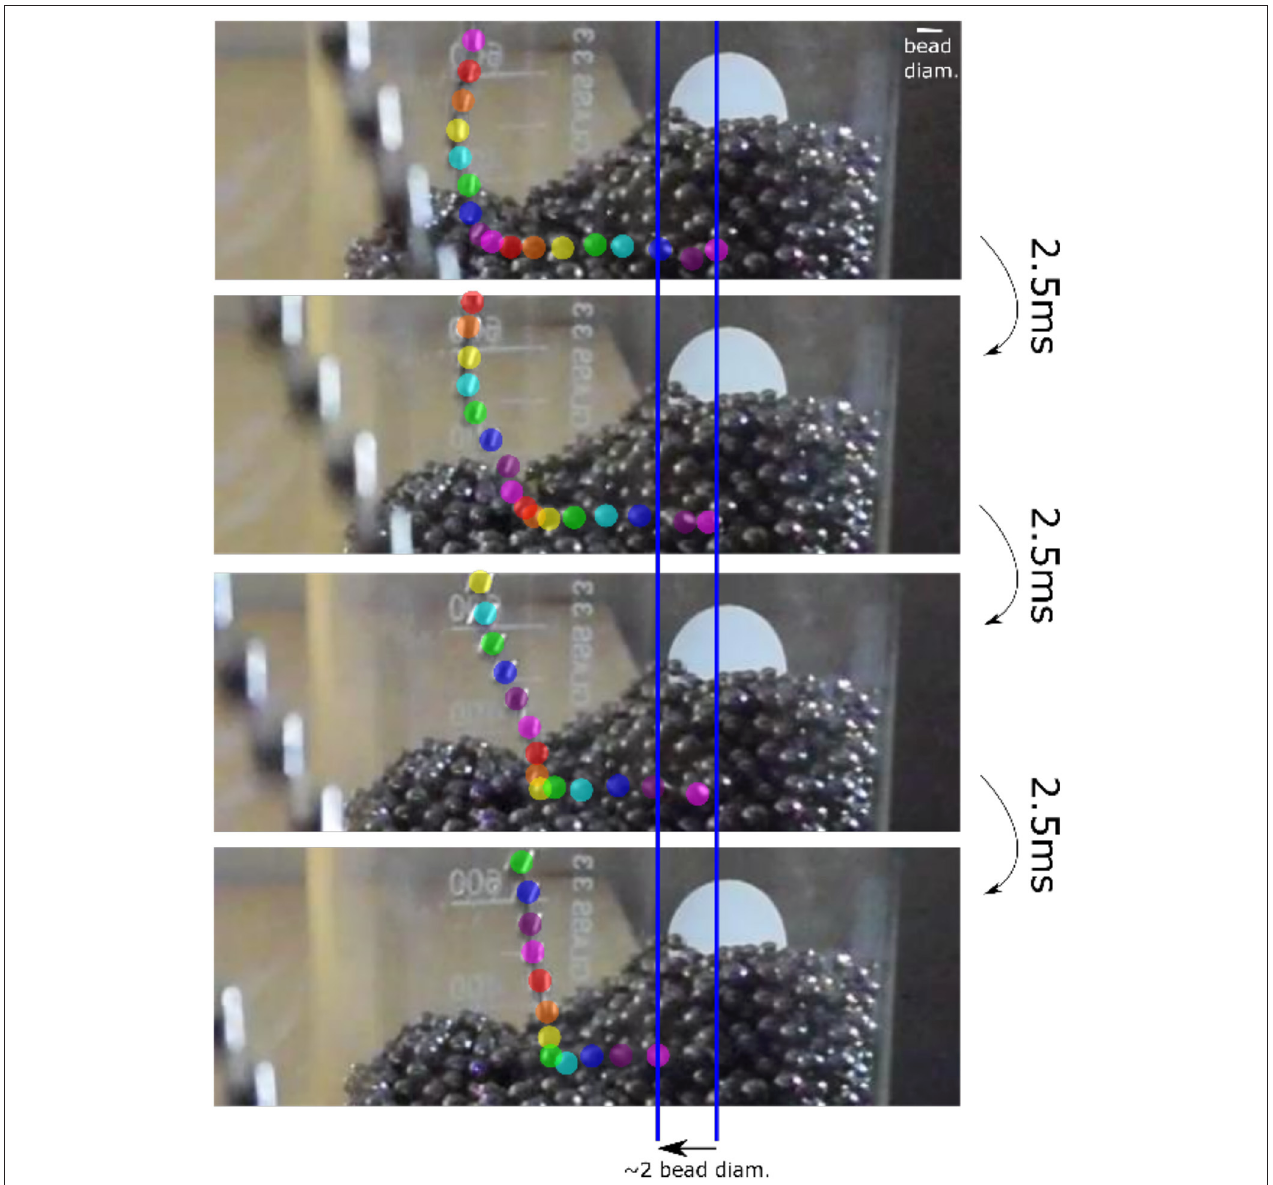
FIGURE 2 | A time sequence of 7.5ms using a 50 m chain of 4.5mm beads. Individual chain beads are traced by different